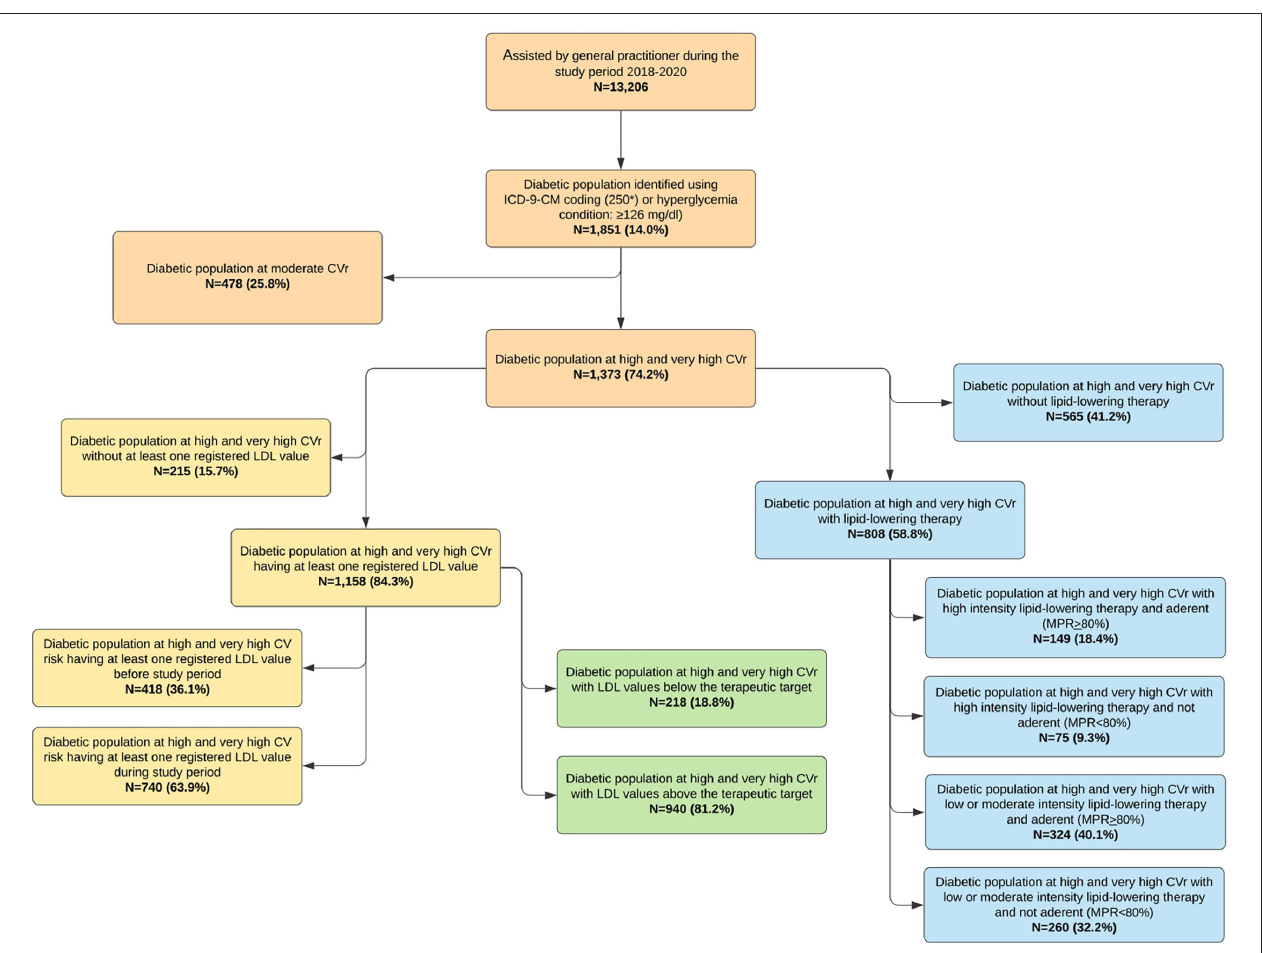
FIGURE 1 | Identification of the study population: focus on the lipidic